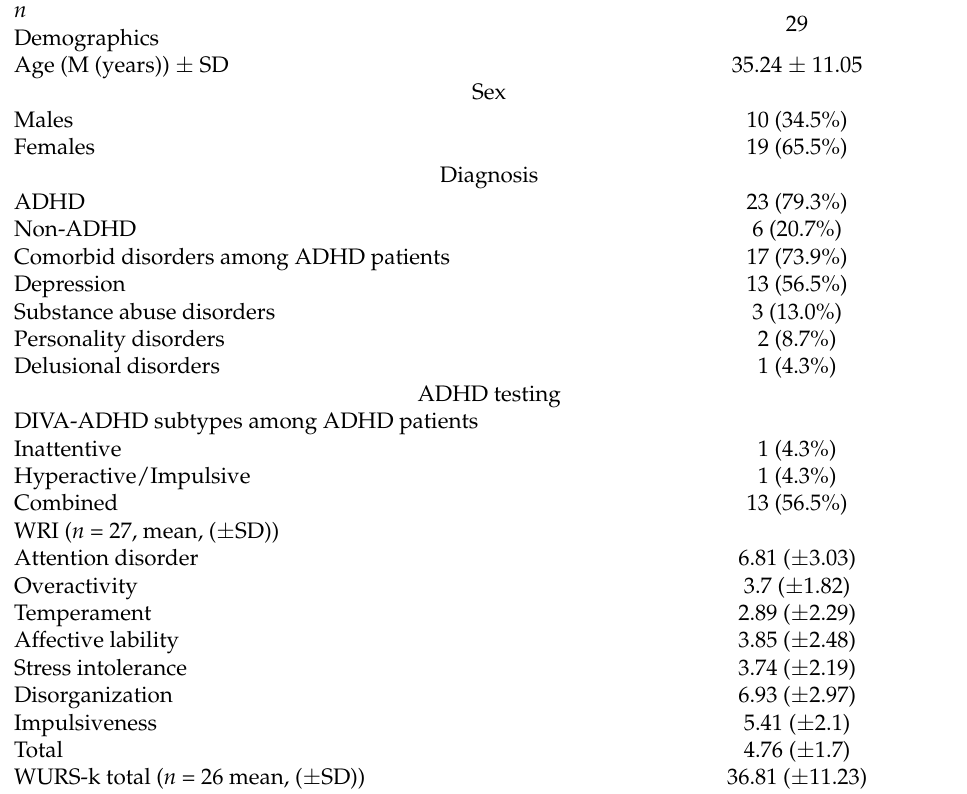
Table 1. Sample and test